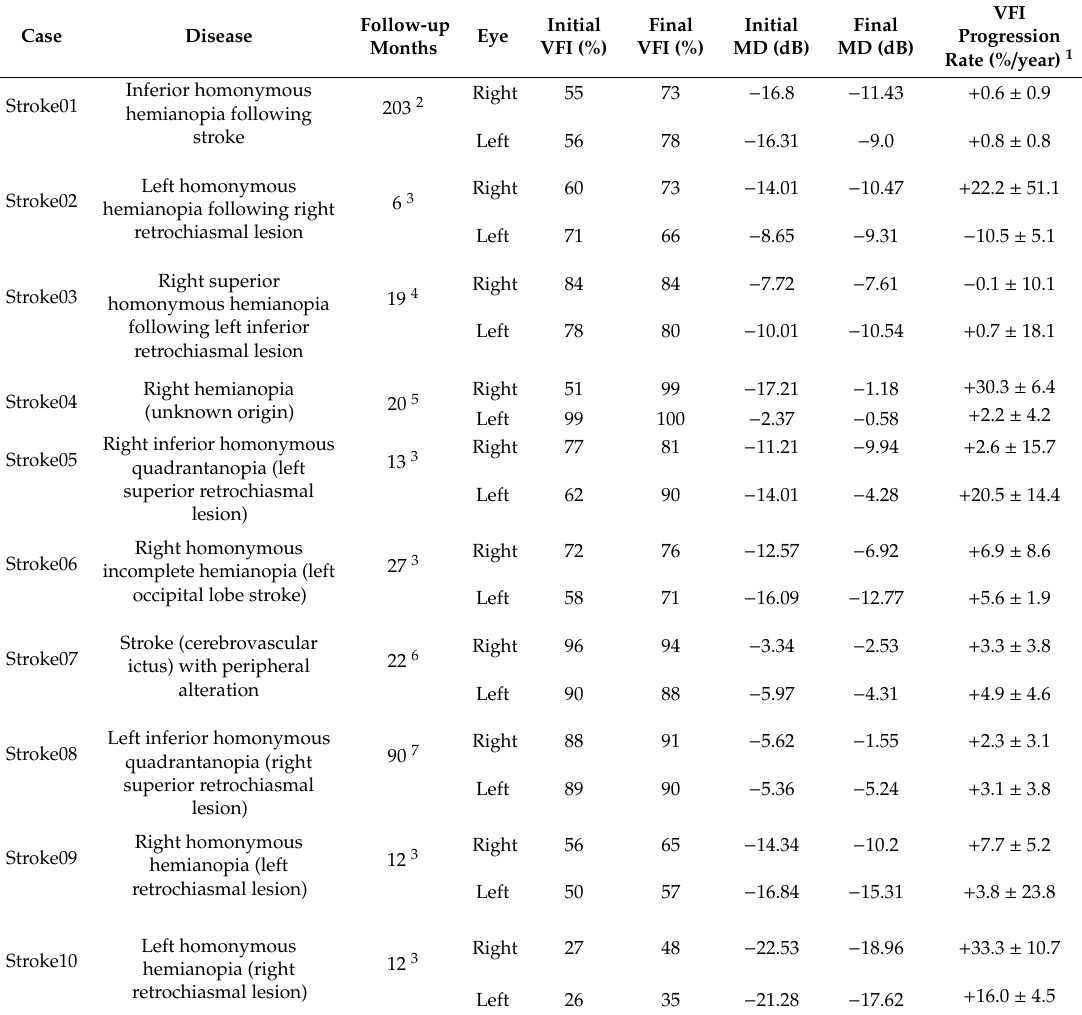
Table 3. Clinical characteristics of homonymous hemianopia and quadrantanopia cases following stroke, VFI and MD follow-up, and progression rate.